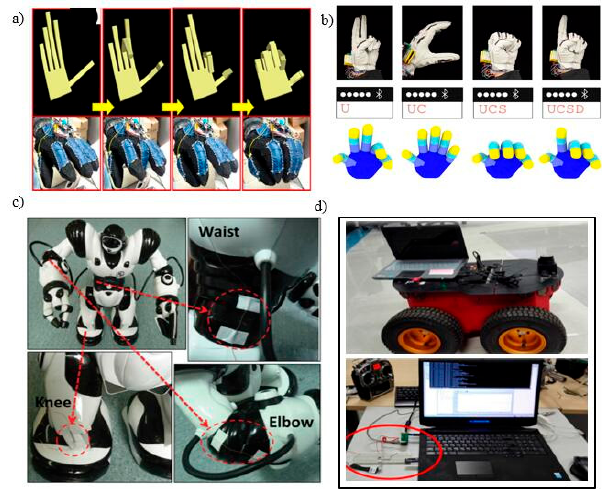
Figure 4. ( a ) A smart glove system made of five strain sensors control the avatar fingers in the virtual environment. Reprinted with permission from [68], Copyright American Chemical Society, 2014; ( b ) A low-cost system for decoding and transmitting human hand gestures by generating digit binary key based on the on/off states of the strain sensors. Reprinted with permission from [81], Copyright PLOS, 2017; ( c ) The robot wore graphene/PDMS-based sensors at movable joints using adhesive tape to detect various kinds of motion. Reprinted with permission from [82], Copyright John Wiley and Sons, 2015; ( d ) A mobile robotic platform controlled by the carbon paper (CP)/PDMS strain sensor. Reprinted with permission from [83], Copyright American Chemical Society, 2016.